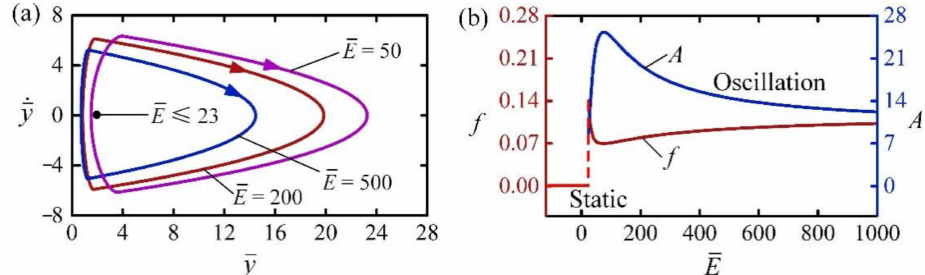
Figure 13. The effect of equivalent modulus on the self-jumping, for I 0 = 2, C 0 = 0.3, H = 4, β = 0.01, . = 0.5, y = 30, and = 0. ( a ) Limit cycles. ( b ) Frequency and g = 1, n g = 200, p y am 0 0